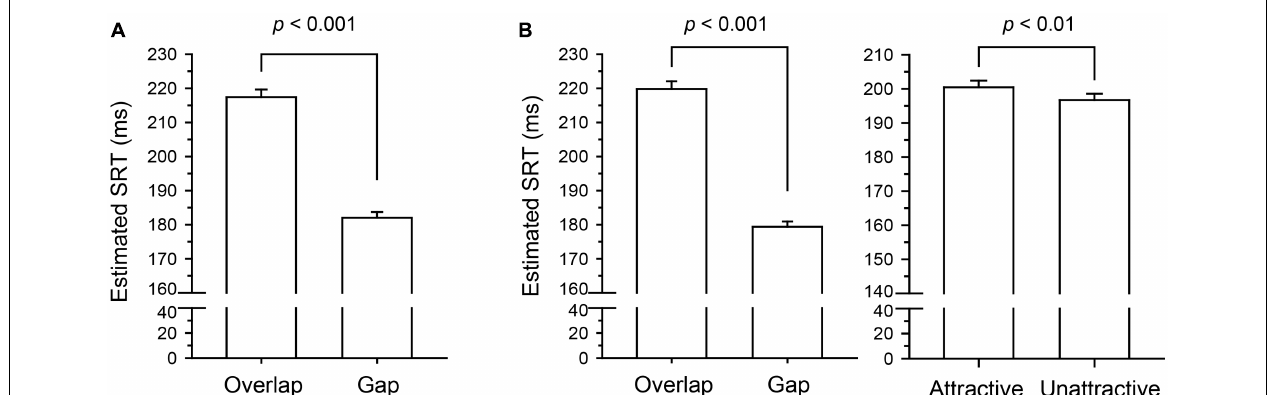
significant effect of the gap manipulation with lower SRTs in the Gap than in the Overlap condition. (B) Model results for the natural faces. The gap effect was qualitatively identical to the results from the morphed faces. In addition, the data yielded an effect of facial attractiveness, with longer SRTs with attractive than with unattractive